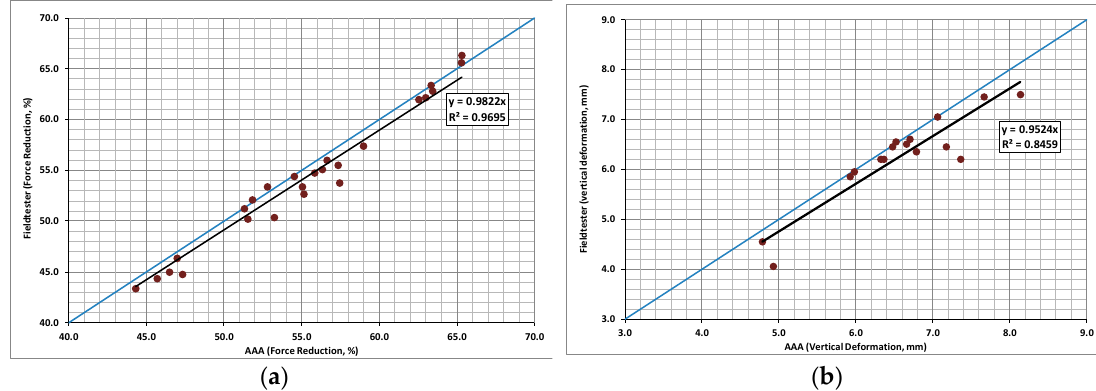
Figure 4. Correlations for the Fieldtester and AAA on a range of laboratory samples and field data, for force reduction (FR) ( a ) and vertical deformation (VD) ( b ). The line of equality is shown, and the best fit lines forced through the origin.